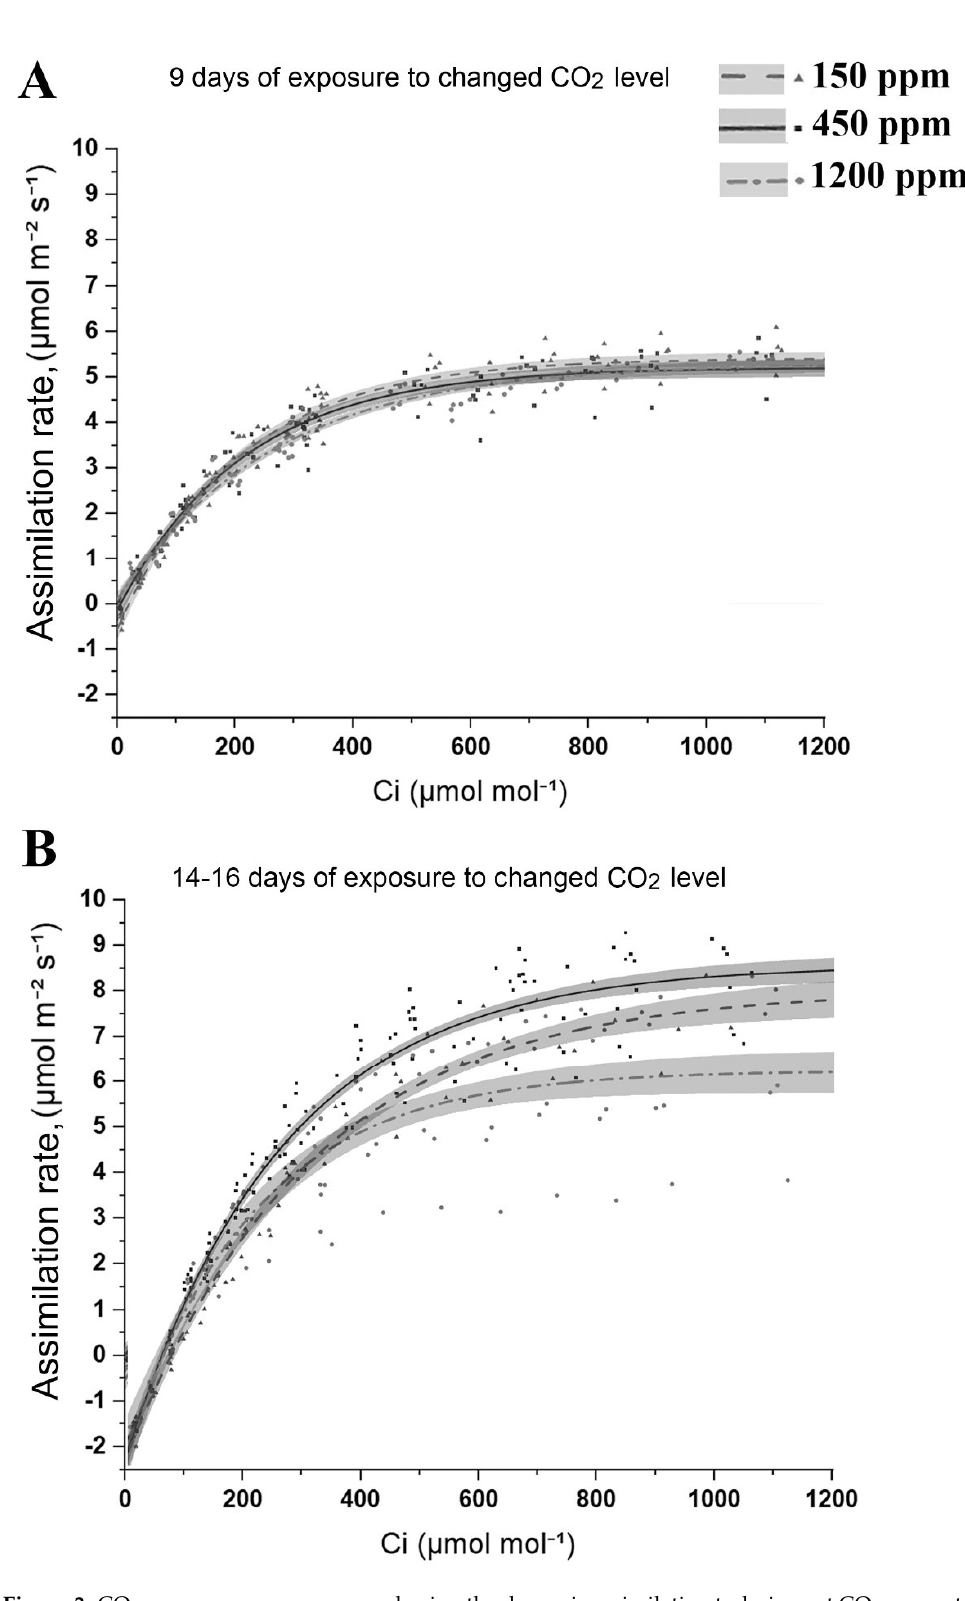
Figure 3. CO 2 response curves measured using the dynamic assimilation technique at CO 2 concentra- tions in the measurement chamber varying from 0 to 1200 ppm in leaves of Arabidopsis plants after 9 ( A ) and 14–16 days ( B ) of exposure to low (150 ppm) and high (1200 ppm) CO 2 level. Assimilation rate in plants of the same age grown in the air with normal (450 ppm) CO 2 level is the control. Curves show the data of a typical